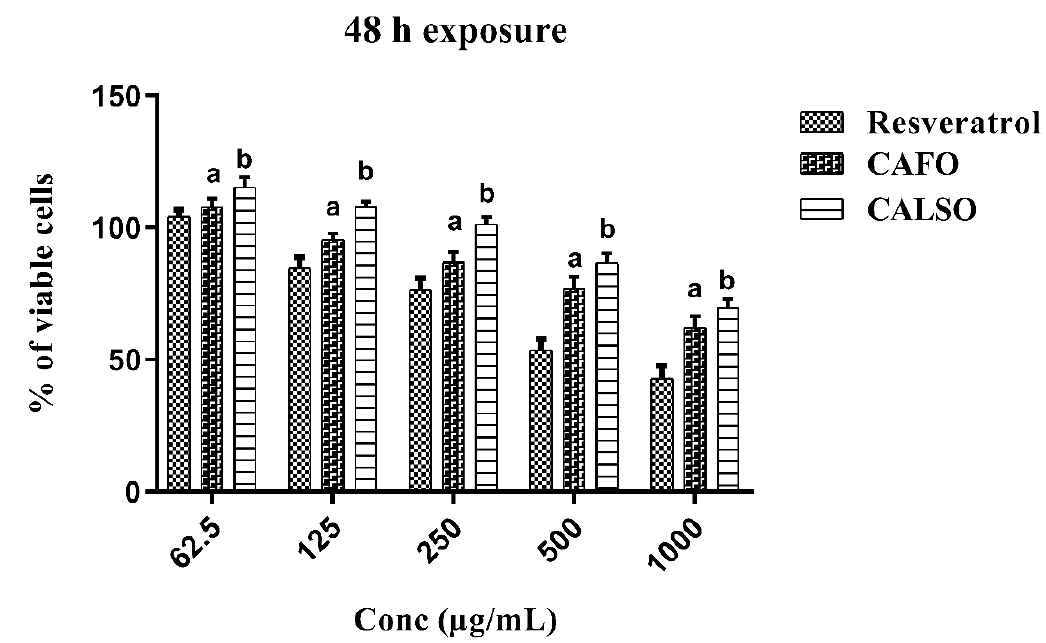
Figure 3. The effects of C. anthemoides essential oils on the cytotoxicity of RAW 264.7 cells in comparison to resveratrol in different concentrations for 48 h ( n = 3). Each bar represents the mean ± S.E.M. Multiple comparisons were completed using two-way ANOVA, followed by Tukey – Kramer as the post-ANOVA test. a Significantly different from the value of the resveratrol group at p < 0.05. b Significantly different from the value of the CAFO group at p < 0.05. CAFO: C. anthemoides flower essential oil; CALSO: C. anthemoides leaves and stem essential oil.